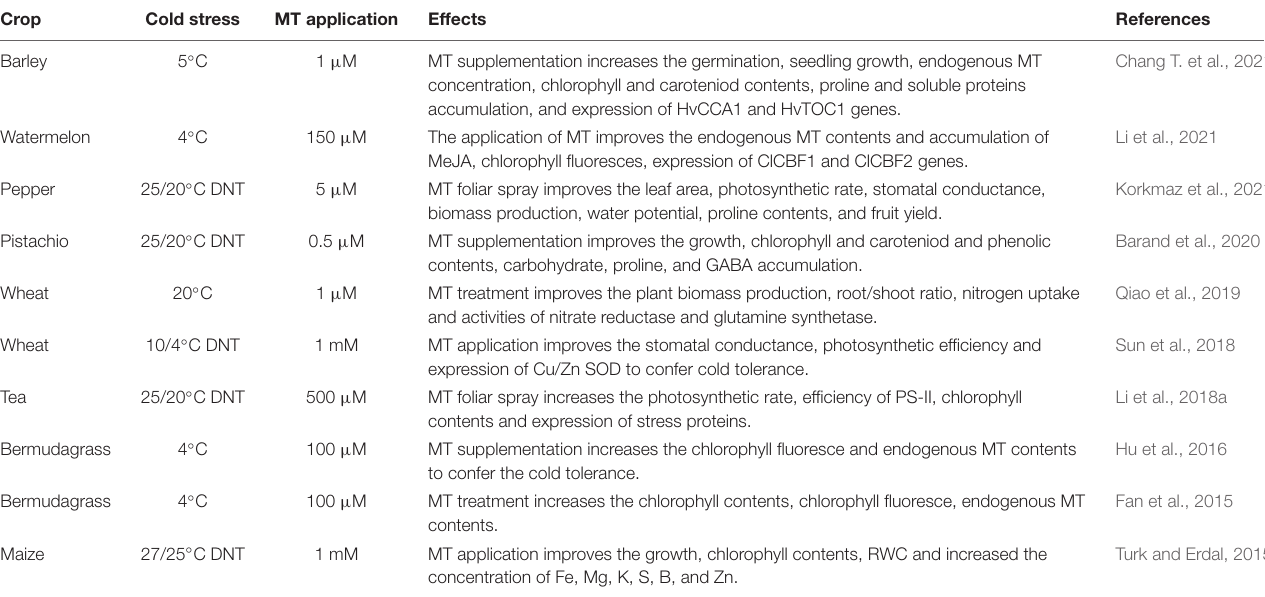
TABLE 2 | Effect of melatonin application on growth and physiological and molecular attributes under cold stress.